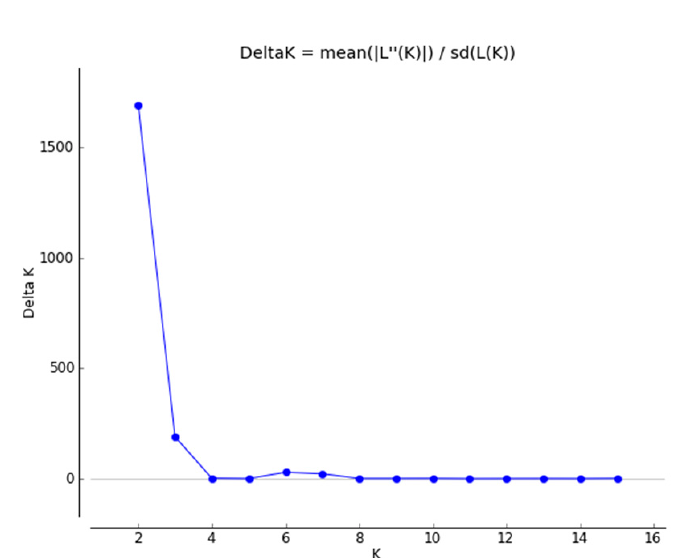
Figure A1. Delta K plot for the Northern Zone.